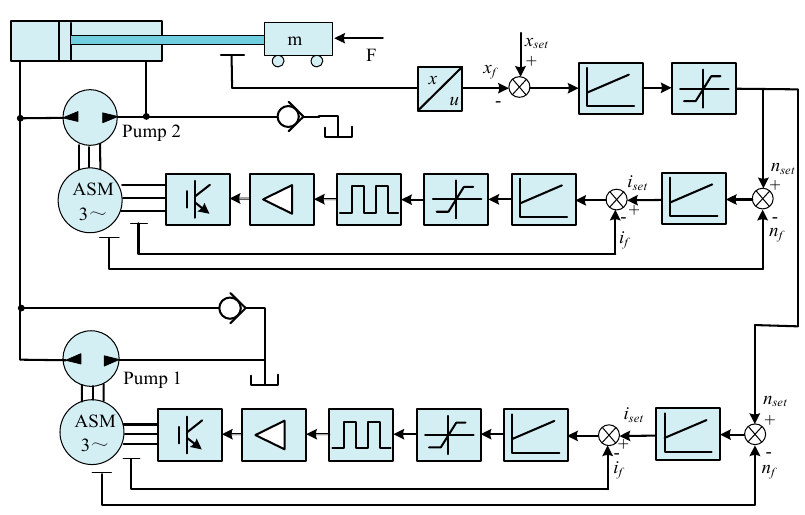
Figure 8. The principle to control differential cylinders with two speed variable pumps.